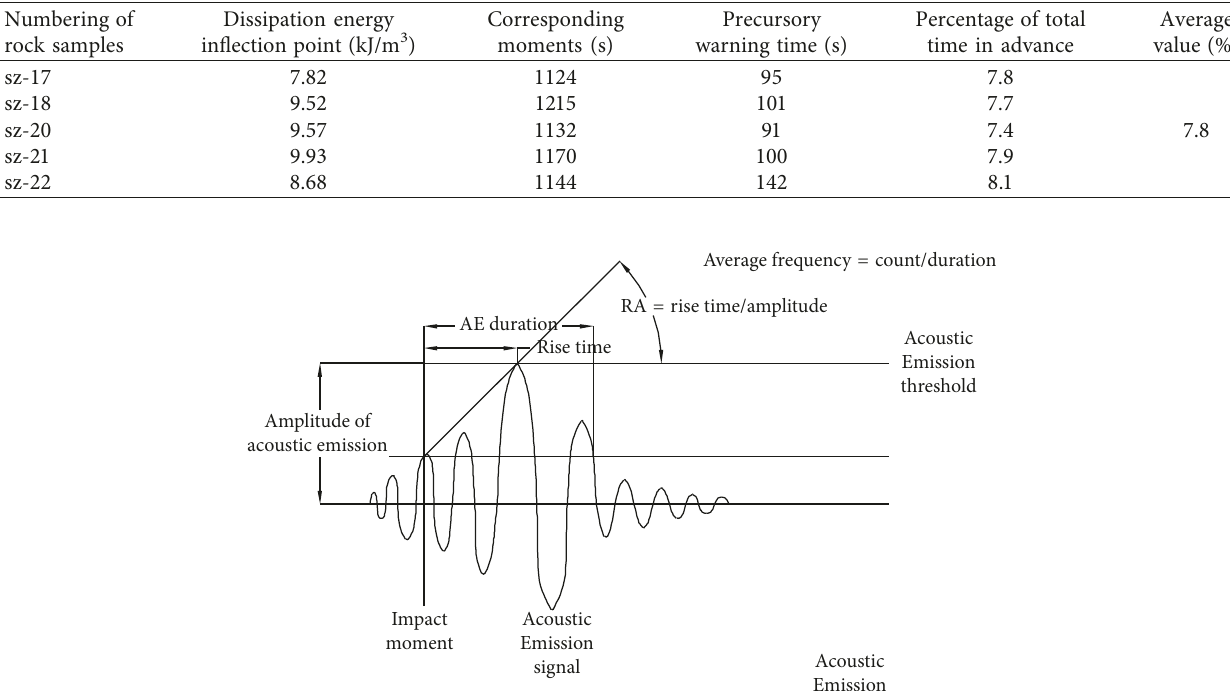
Table 3: Dissipative energy table of body strain precursory